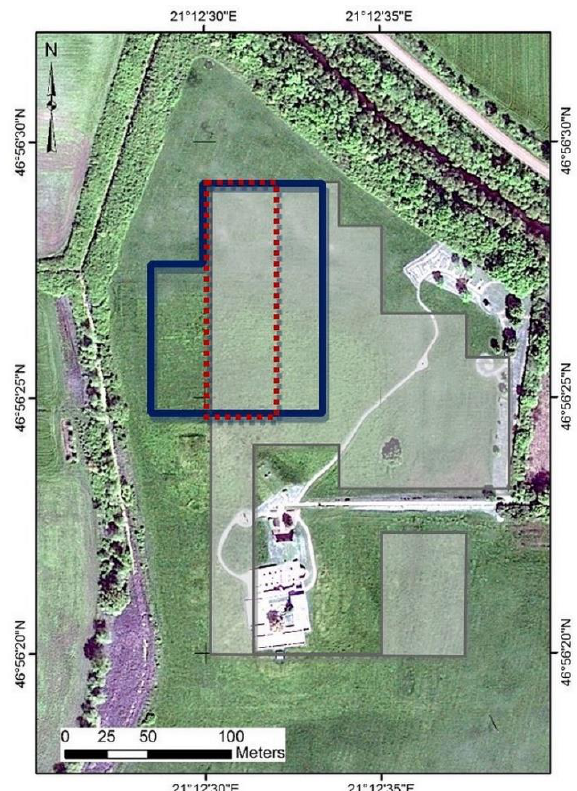
Figure 1. Area covered from the different techniques: Grey and blue polygons indicate the areas covered from the geophysical surveys (magnetic and GPR survey, respectively), the red polygon indicates the area covered from the ground spectroradiometric measurements (Latitude: 46°56′24.36″; Longitude: 21°12′32.67″) (source [26]).